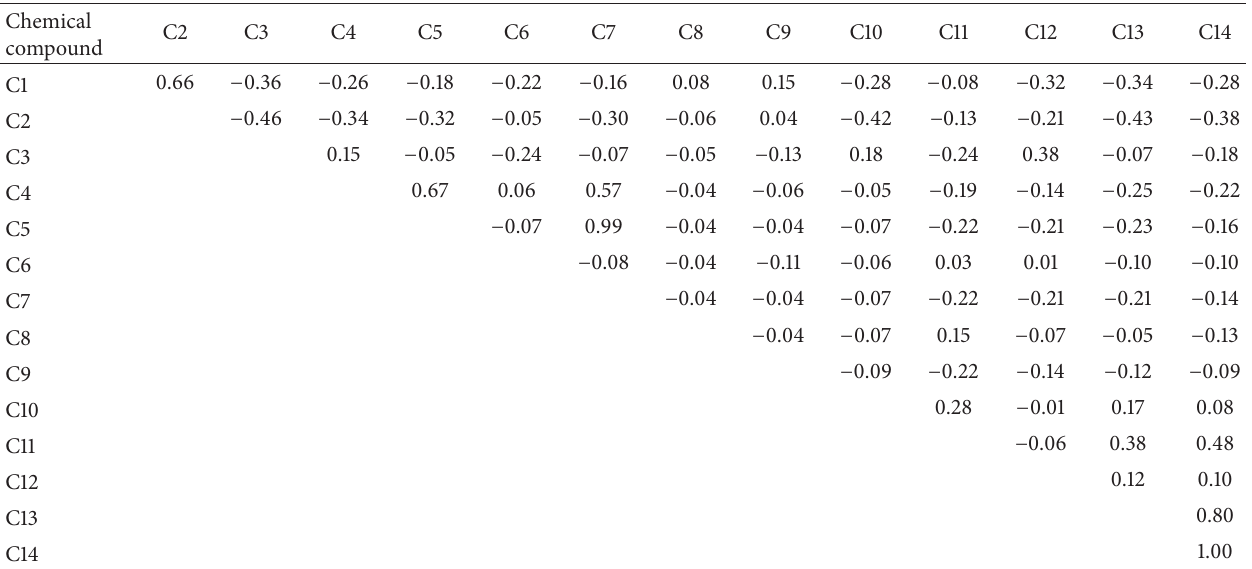
Table 3: Correlation coefficients for the most abundant chemical constituents in basil essential oil. Chemical compound